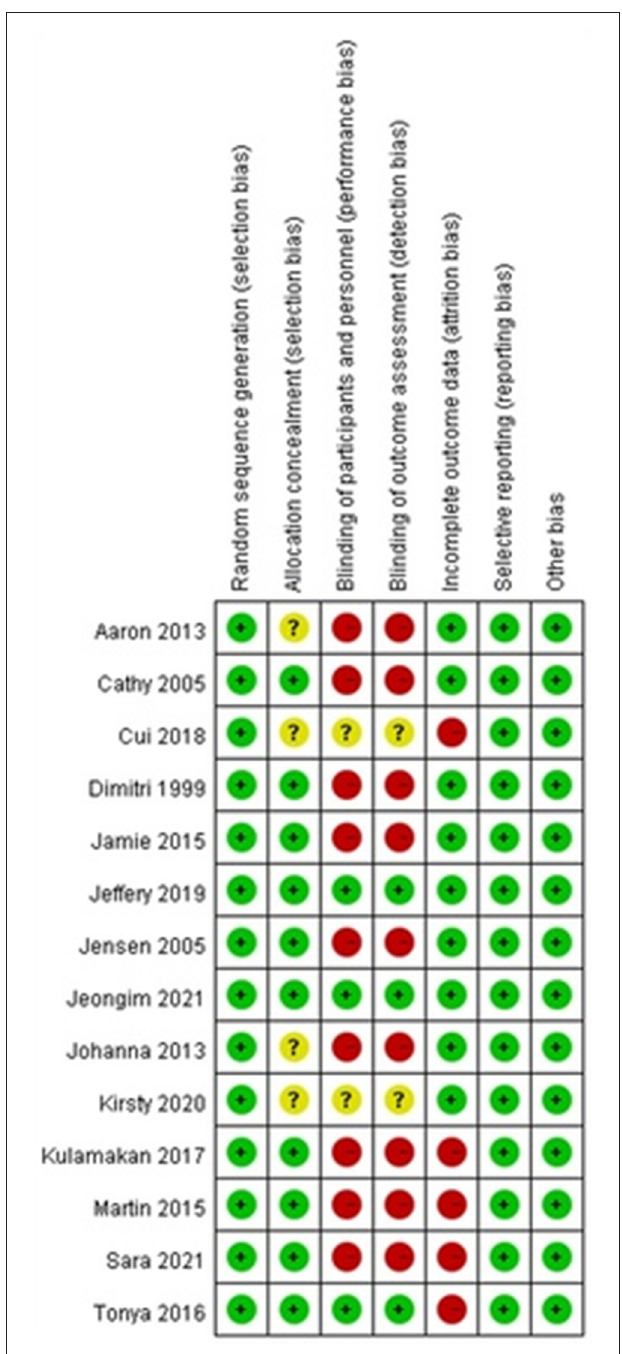
FIGURE 2 | Risk of bias summary.